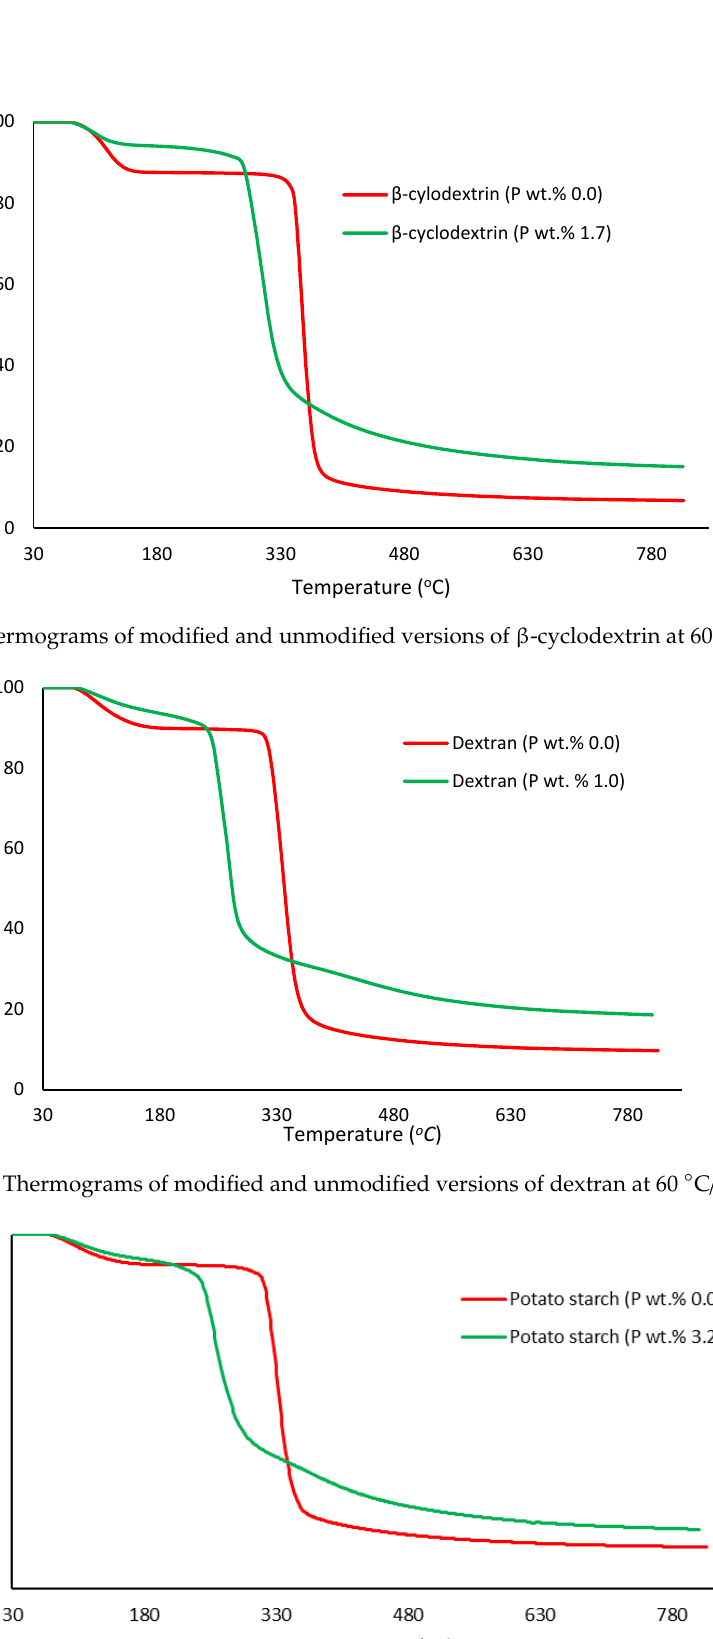
Figure 6. Thermograms of modified and unmodified versions of tamarind at 60 °C/min. 010 20 3040